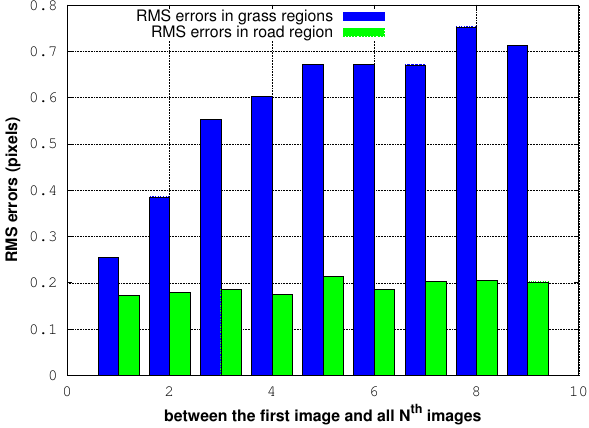
Figure 16. Residuals of the 3D rotation estimation between the first image and all other images in grass and road